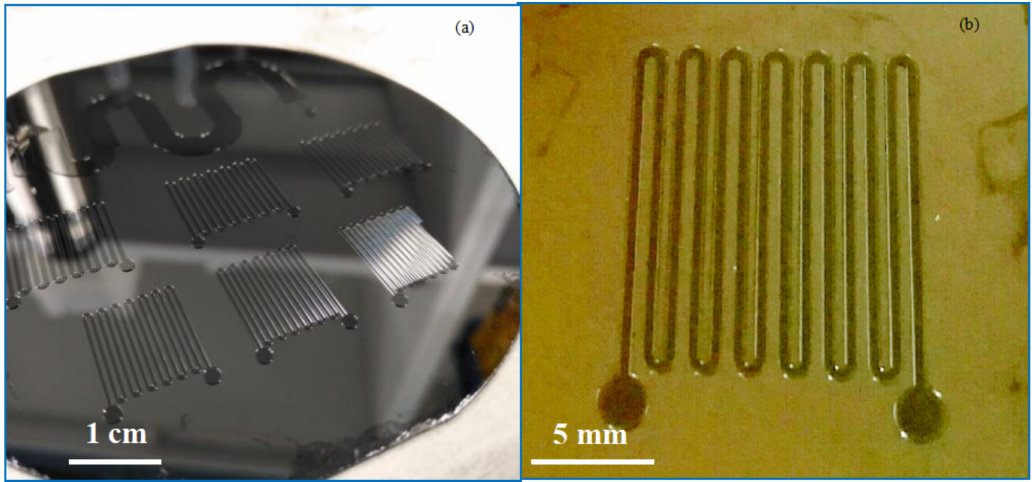
Figure 3. The fabricated SU-8 master mold for the following PDMS casting. ( a ) a few molds on a 4-inch silicon wafer; ( b ) close-up view of one mold for channels with straight